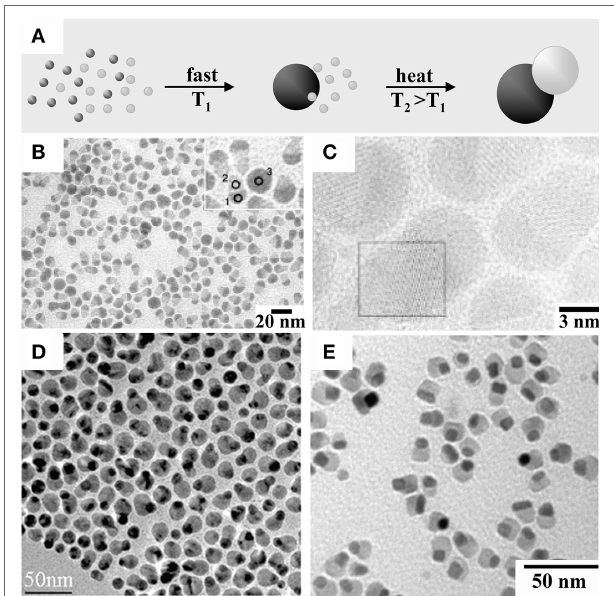
FIGURE 5 | Examples of magnetic heterostructured nanocrystals (MHNCs) synthesized by self-controlled nucleation-growth mechanisms . (A) Sketch of the mechanism [adapted from Casavola et al. (2008) with permission, copyright Wiley-VCH Verlag GmbH & Co. KGaA]. (B–E) Low-magnification transmission electron microscopy overviews and selected high-resolution transmission electron microscopy images of: (B,C) acorn-shaped Co 9 S 8 –PdS x hetero-dimers [reproduced from Teranishi et al. (2004) with permission, copyright American Chemical Society]; (D) Au–Ni hetero-dimers [reproduced from Wang and Li (2010) with permission, copyright American Chemical Society]; (E) peanut-shaped FePt–Fe 3 O 4 hetero-dimers [reproduced from Figuerola et al. (2008) with permission, copyright American Chemical